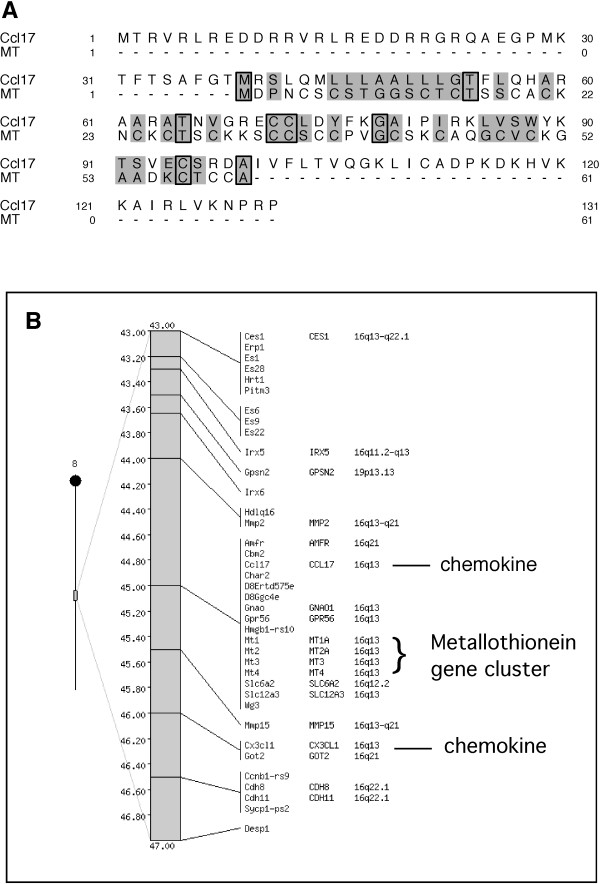
Structural features of metallothionein gene and protein. A: Clustal alignment of Ccl17 and metallothionein (MT) protein sequences. Amino acid similarity is set at 85% (gray). Identical amino acids are boxed. B: Mouse chromosome 8 showing expanded region from map position 43 to 47 shown on left. Homologous human genes and their chromosomal map positions are indicated on the right. Synteny map generated by the Mouse Genome Database [63].